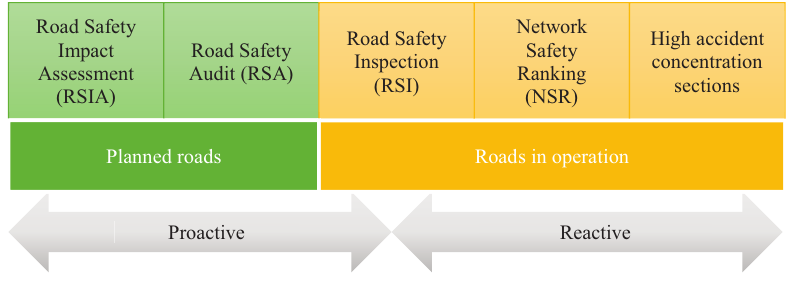
Figure 3. The methods of safety management of roads (Strnad,